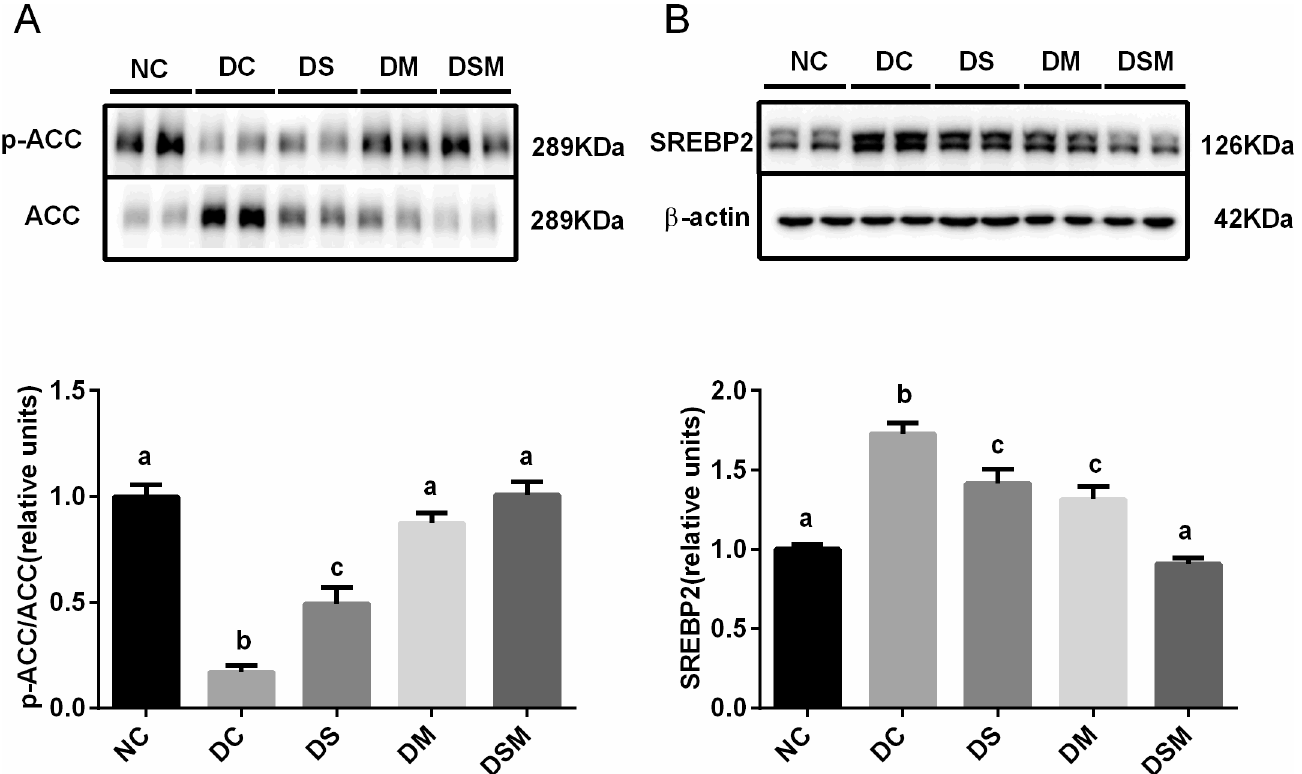
Fig 4. Combined intervention of swimming plus metformin ameliorates the hepatic de novo lipogenesis under GDM condition. (A) Levels of phosphorylated ACC were normalized to total ACC in the livers treated with swimming or metformin or both combined. (B) Expression of SREBP2 were normalized to β -actin in the livers intervened by swimming or metformin or both combined. The values represent the mean ± SEM, n = 10/group. The columns with different letter (a, b, c) are significantly different, P < 0.05 (ANOVA, SNK). All data in this figure are representatives of three independent experiments. NC: normal control group, DC: GDM control group, DS: GDM treated with swimming group, DM: GDM treated with metformin group, DSM: GDM treated with swimming plus metformin